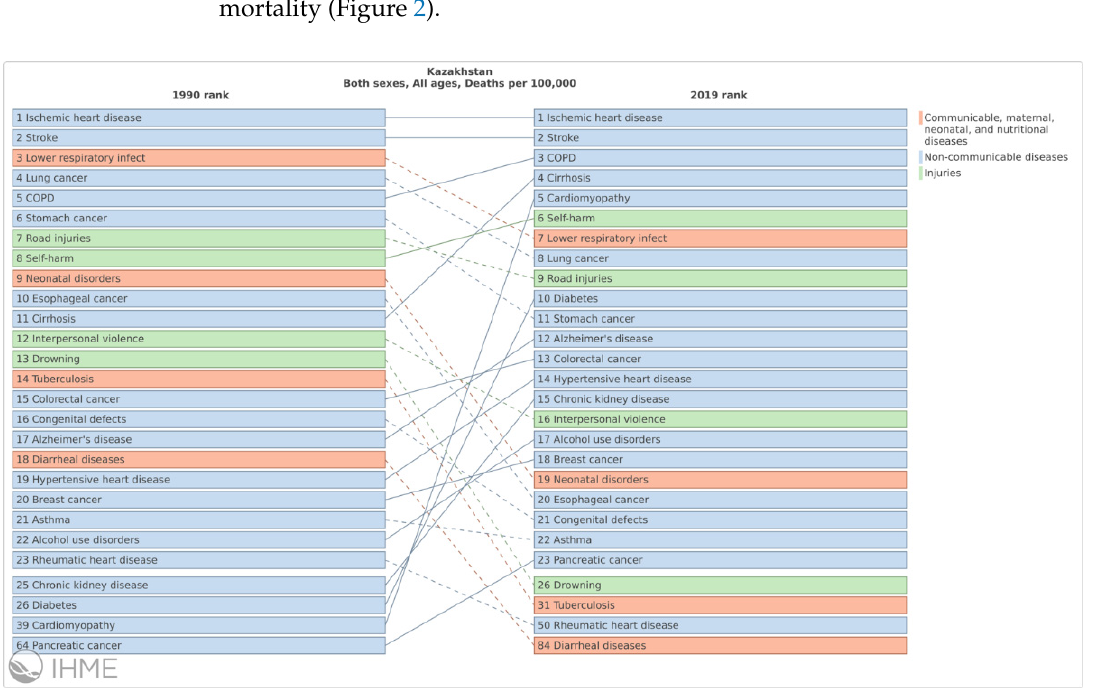
Figure 2. Leading causes of death. Source: Institute for Health Metrics and Evaluation (IHME). https://vizhub.healthdata.org/gbd-compare/ (accessed on 22 November 2021).